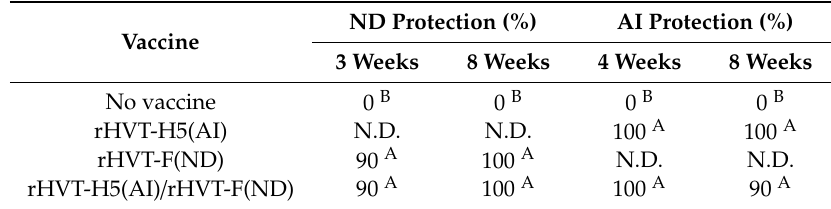
Table 1. Clinical protection against challenges with vNDV and H5-HPAIV strains in SPF WL chickens